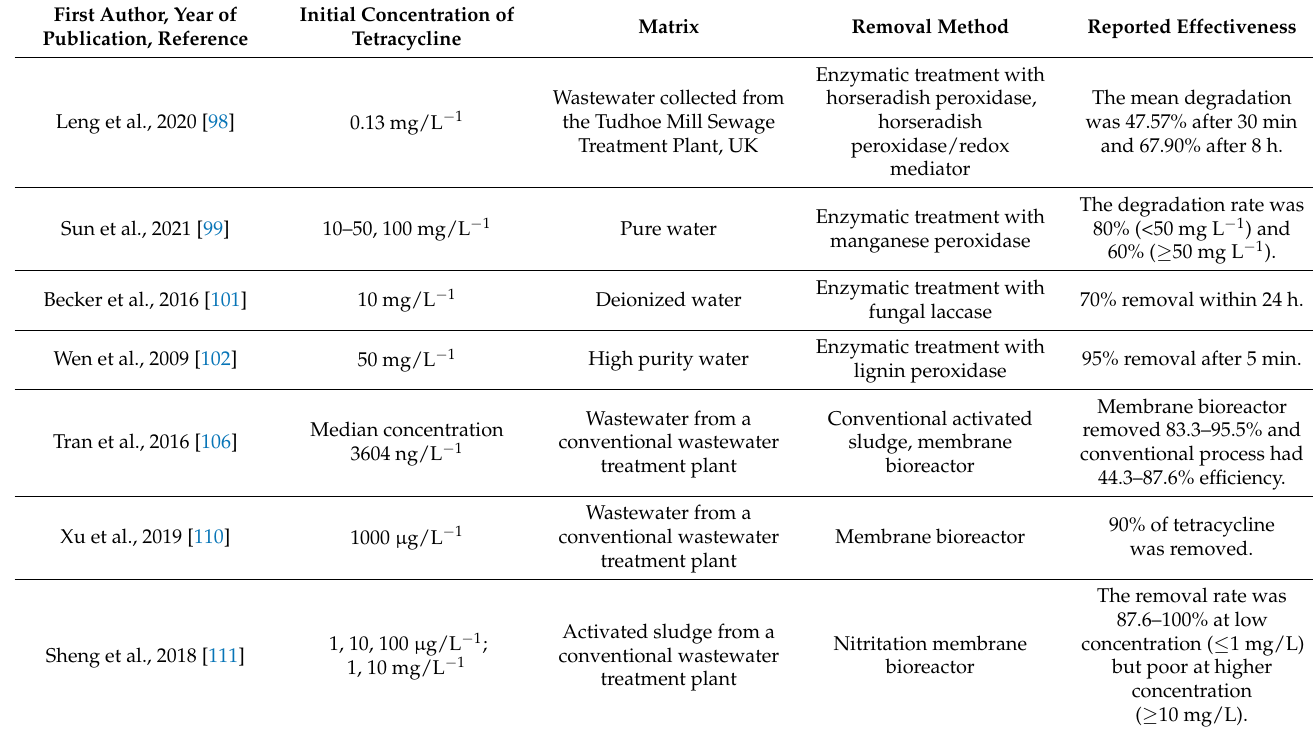
Table 3. Studies on the effectiveness of biological methods in removal of